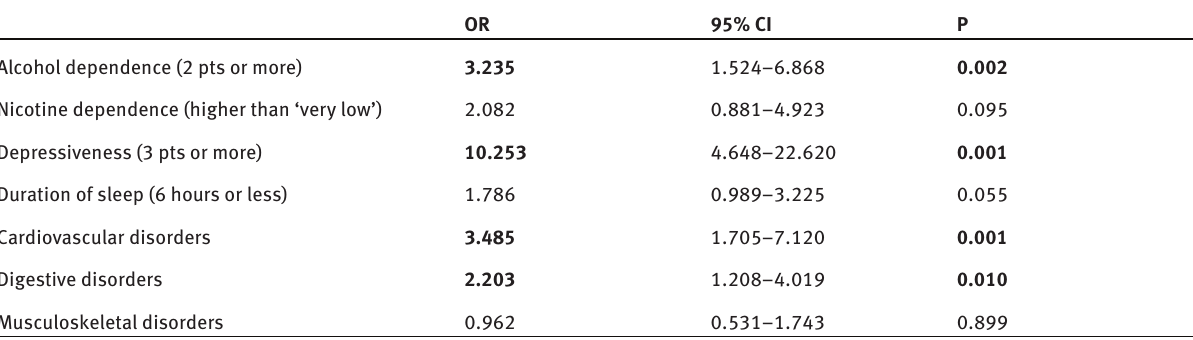
Table 6: Associations of professional burnout with health disorders and behaviors.